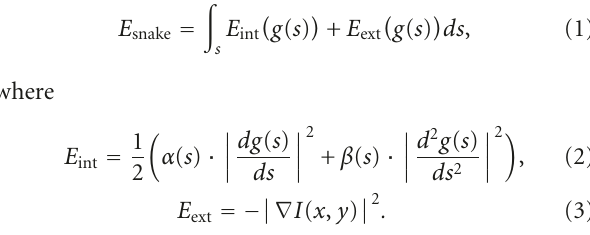
Figure 1: B-spline interpolation. c ( k ) are the coe ffi cients, g ( k ) are the B-spline points, and g ( s ) is the curve that interpolates g ( k